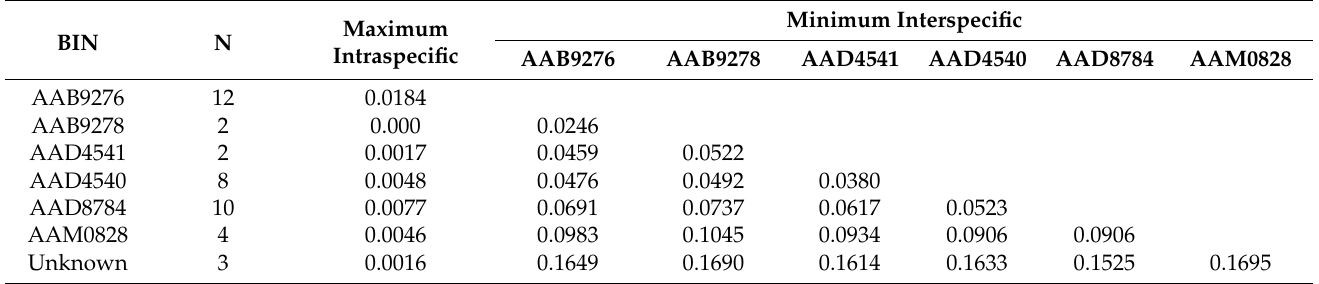
Figure 2. Neighbor-joining representation of Magnisudis COI sequences. The percentage of replica trees in which associated sequences cluster together in a bootstrap test (2000 replicates), as shown below the branches. The bar shows the unit for the number of base differences per site (p-distance). The analysis included 41 nucleotide sequences. All ambiguous positions were removed for each sequence pair (pairwise deletion option). There were a total of 651 positions in the final dataset. The Spanish coastal record is represented in bold type. The diagram includes the correspondence between each grouping and its BOLD BIN. Table 2. Maximum intraspecific and minimum interspecific p ‐ distances in Magnisudis groups.